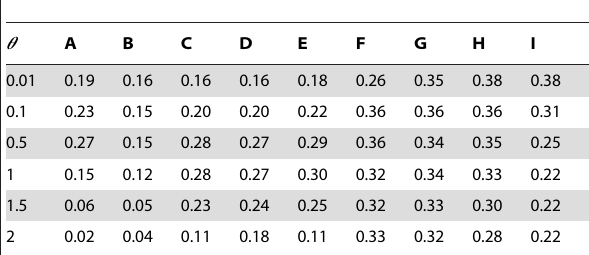
Table 2. Proportion of variance explained (R 2 ) by path overlap and divergence variables for different solutions and different values of h